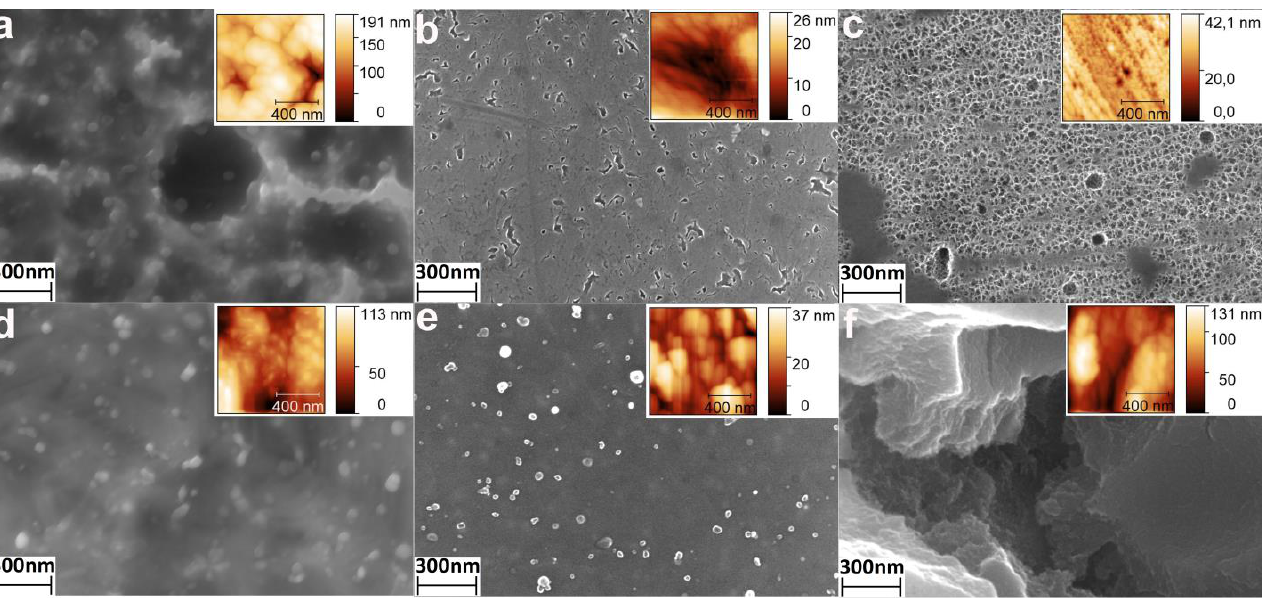
Figure 3. SEM images (300 nm scale bars) of nitinol surface for samples: ( a ) HCl/H 2 SO 4 -30 min, ( b ) H 2 SO 4 /H 2 O 2 -30 min, ( c ) NH 4 OH/H 2 O 2 -30 min, ( d ) HCl/H 2 SO 4 -120 min, ( e ) H 2 SO 4 /H 2 O 2 -120 min, ( f ) NH 4 OH/H 2 O 2 -120 min. The insets show the AFM surface topographies of the corresponding samples.